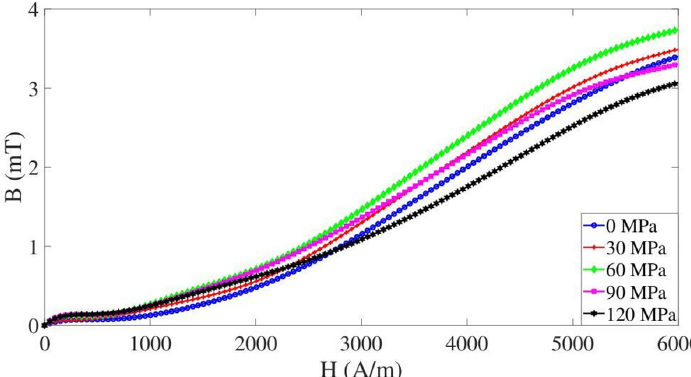
Figure 12. Magnetization curves for specimen 2 under different levels of stress at angle 0° .